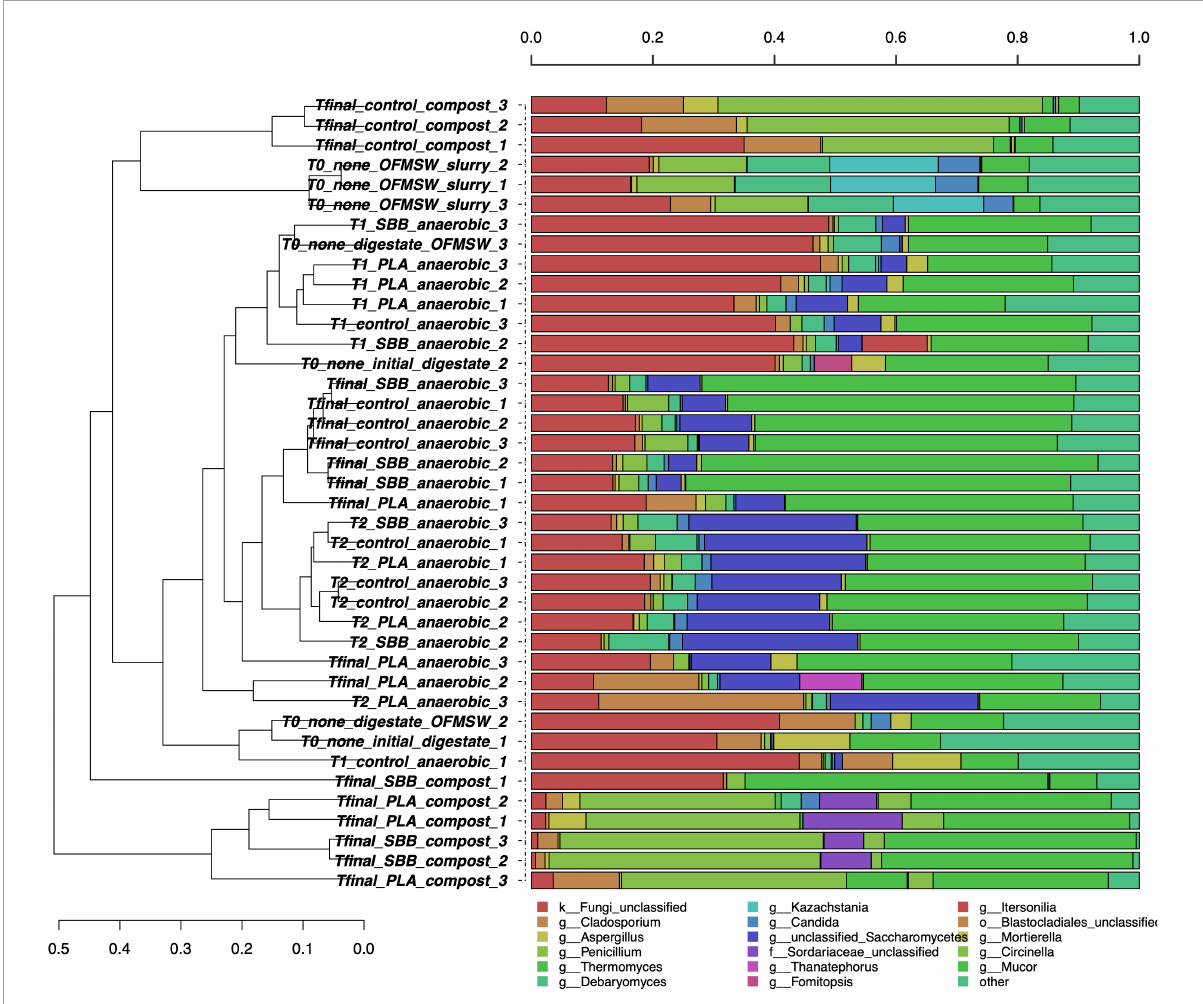
FIGURE4 Hierarchical clustering of fungal sequences using the average linkage algorithm at the genus level for taxa with at least ≥ 5% participation in a single sample. Taxa with low contributions were added to the “other” group. PLA, polylactic acid; SBB, starch-based bioplastic; OFMSW, organic fraction of municipal solid